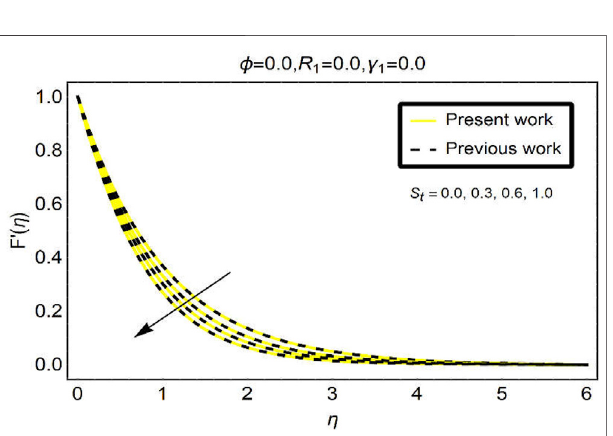
Figures 6 – 8 explain to analyze the behavior velocity gradient G ′ of [(MgZn 6 Zr)/C 8 H 18 ] nf over a 3D stretchable surface. The results in Figures 6 – 8 , respectively. are plotted for R 1 , S t , and γ 1